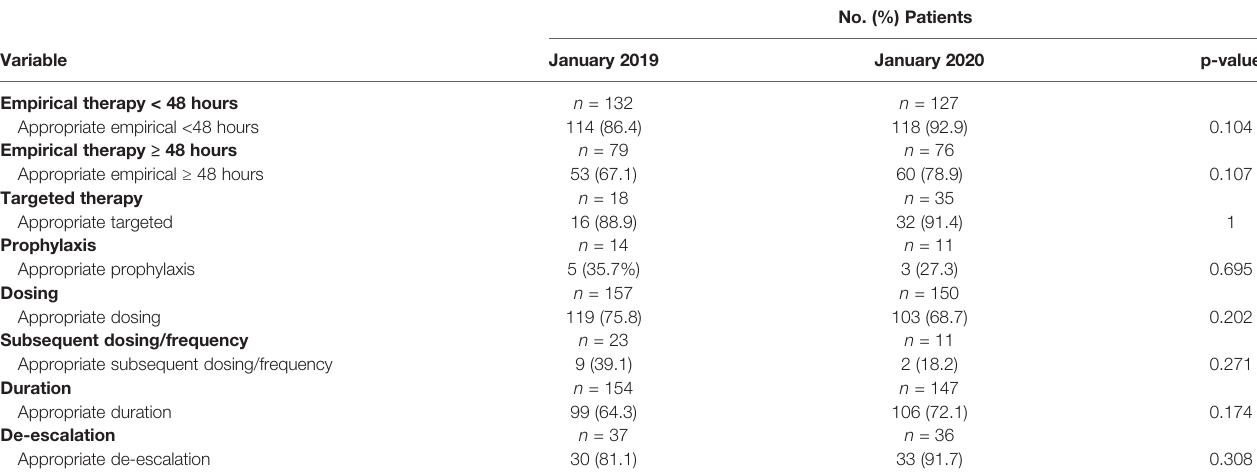
TABLE 2 | Percentage of appropriateness of physicians ’ prescribing patterns in terms of carbapenem therapy in January 2019 and January 2020.